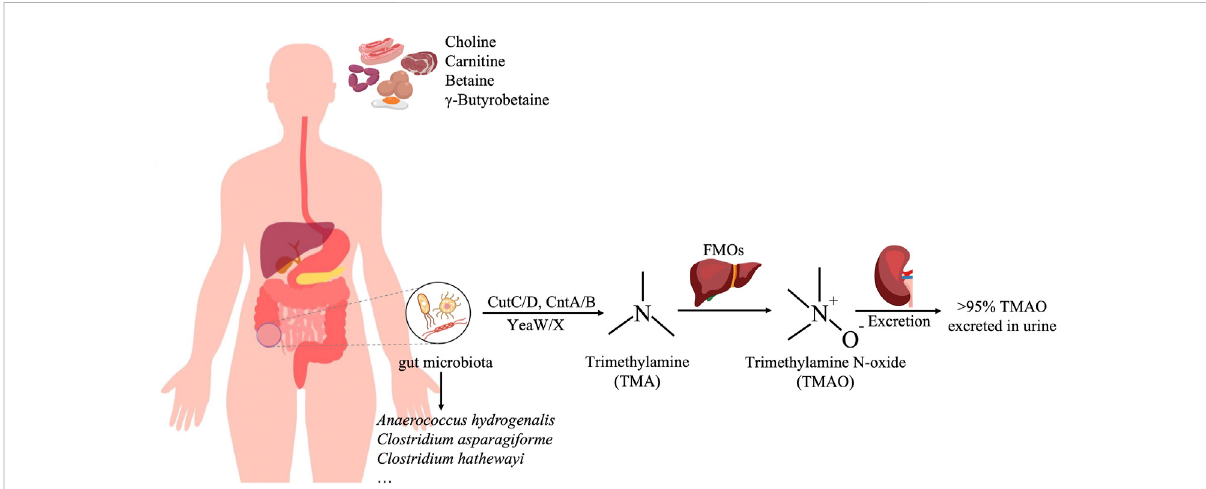
FIGURE 1 The production process of TMAO. Red meat, egg, and sausage are rich incholine and carnitine, whichare metabolized by thegut fl ora, such as Anaerococcus hydrogenalis , Clostridium asparagiforme , and Clostridium hathewayi , into trimethylamine (TMA) in the colon, and then oxidized to TMAO in the liver by Flavin-containing monooxygenase 3